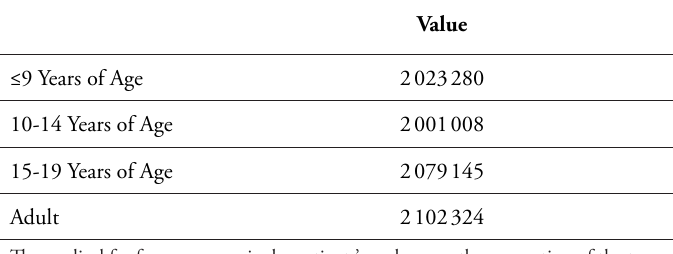
Table 4: Cost Parameters for Surgery (JPY, estimated by standard of care)